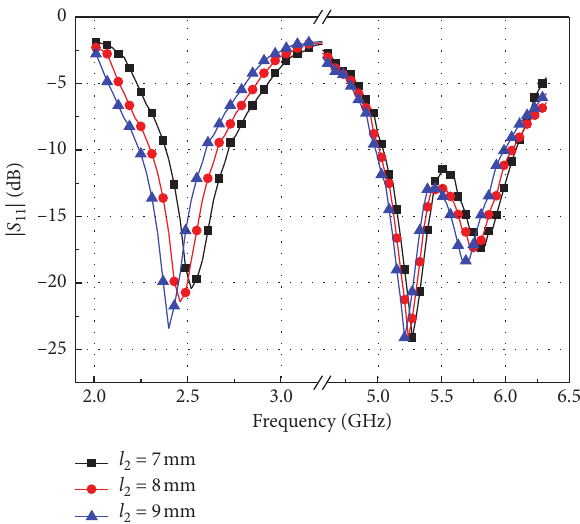
Figure 5: The simulated | S 11| for different w